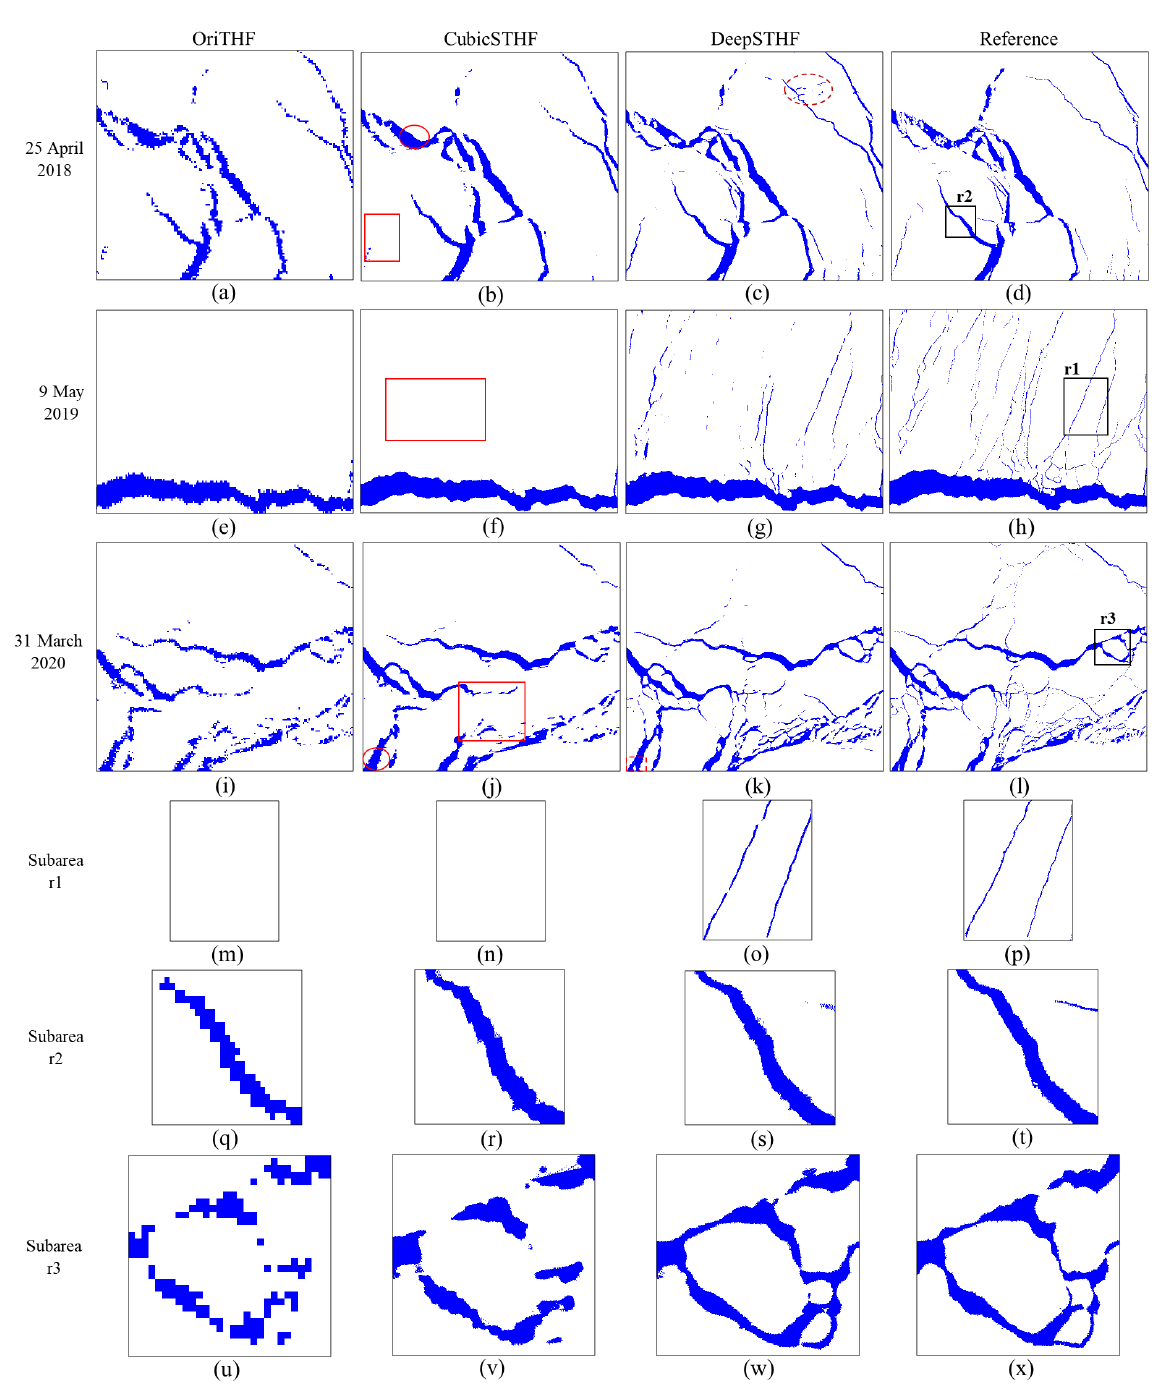
Figure 13. The lead maps generated from the MODIS IST images using the three methods. The images were acquired on (a–d) 25 April 2018, (e–h) 9 May 2019, and (i–l) 31 March 2020. The lead and ice-covered areas are marked in blue and white, respectively. (a, e, i, m, q, u) The results of the OriTHF method, (b, f, j, n, r, v) the results of the CubicSTHF method, and (c, g, k, o, s, w) the results of the DeepSTHF method. The black rectangles in panels (d) , (h) , and (i) represent the subareas. The red rectangles in panels (b) , (f) , and (j) represent the lead networks that have been mapped by the CubicSTHF method. The red ellipses in panels (b) and (j) show the ice-covered regions that have been misclassified as leads by the CubicSTHF method. The red dashed rectangle in panel (k) represents the ice-covered areas that have been correctly classified by the DeepSTHF method. The red dashed ellipse in panel (c) shows the pixels misclassified as leads by the DeepSTHF method due to the errors in the ice surface